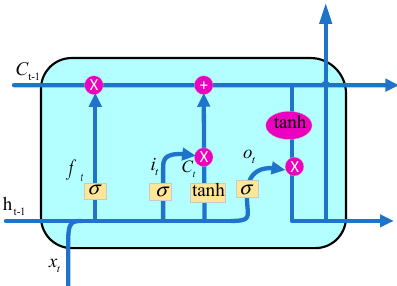
Figure 1. Long short-term memory (LSTM) hidden layer cell structure.